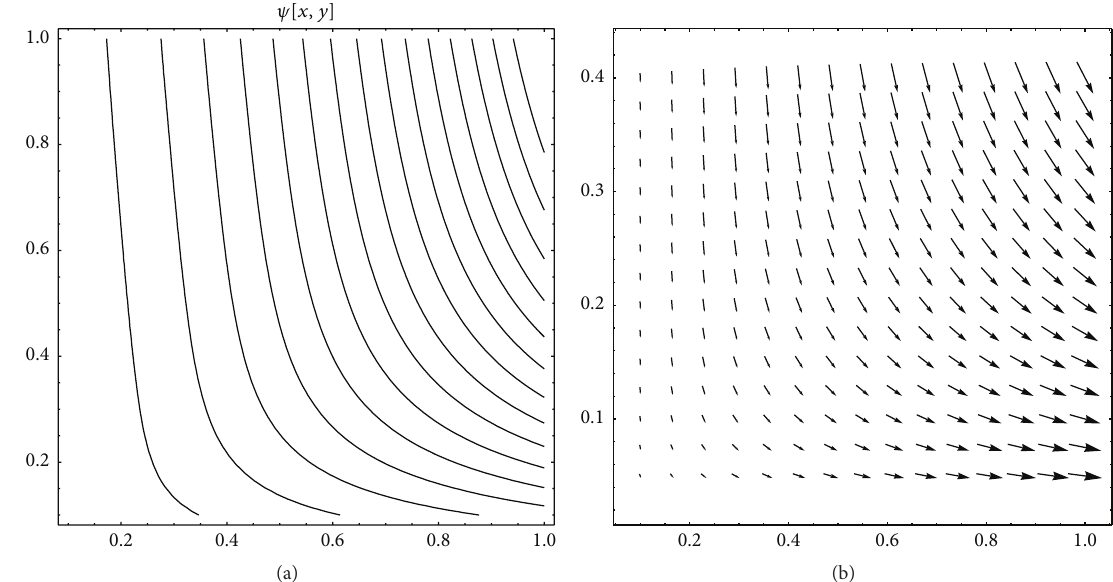
Figure 7: Development of (a) stream function and (b) velocity vector field for viscoelastic boundary layer ( 𝐶 = 0 ).